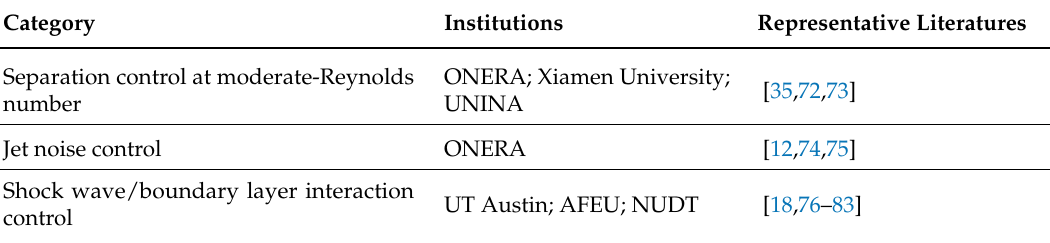
Table 2. Institutions involved in the application studies of plasma synthetic jet actuators. ONERA–The French Aerospace Lab; UNINA–The University of Naples Federico II; UT Austin–The University of Texas at Austin; AFEU–Air Force Engineering University; NUDT–National University of Defense